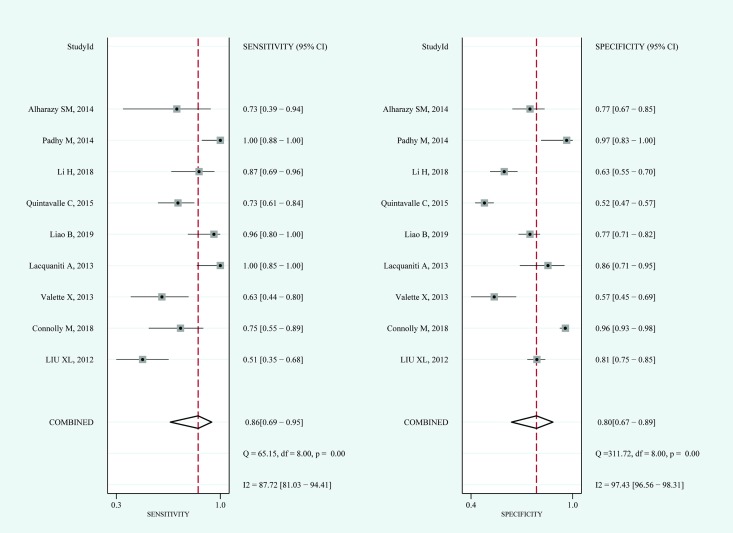
Coupled forest plots for the pooled sensitivity and specificity of blood NGAL for the diagnosis of CIN.Dots in squares represent sensitivity and specificity. Horizontal lines represent the 95% confidence interval (CI) for each included study. The pooled estimate is based on the random-effects model. Heterogeneities evaluation, I2 with 95% CIs and Q are provided. Q is Cochrane heterogeneity statistic and df is the degrees of freedom.